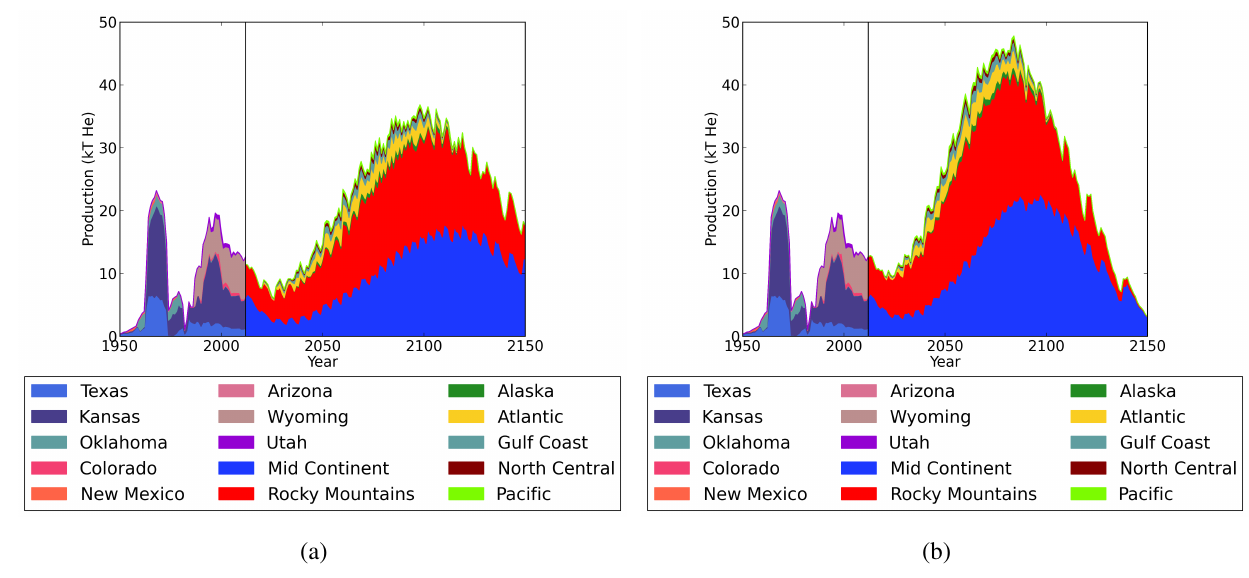
Figure 4. Projection of helium production in the USA by region: ( a ) regular growth and ( b ) high growth.